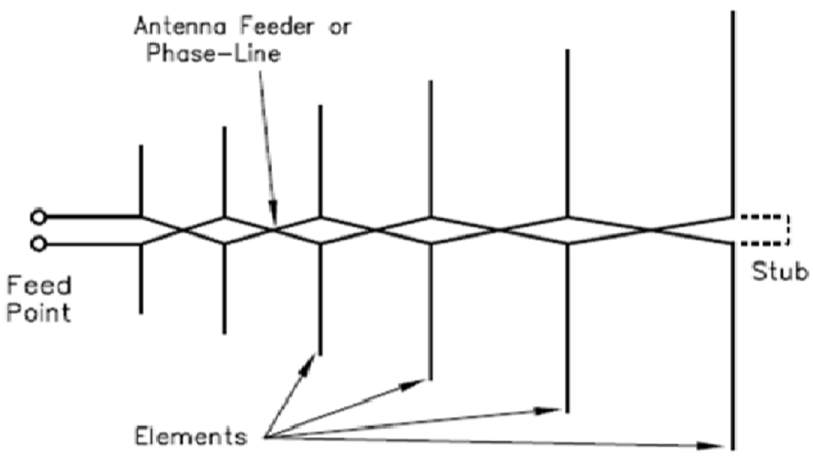
Figure 9. Log-periodic dipole array antenna